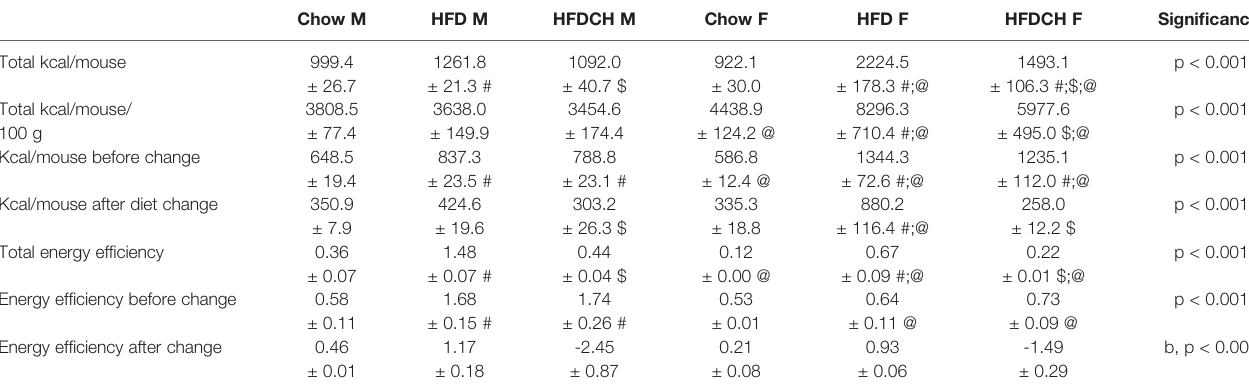
TABLE 4 | Energy intake parameters in male (M) and female (F) mice exposed to chow or to a high-fat diet (HFD) for 12 weeks, or 8 weeks of HFD intake and changed to a chow diet for 4 weeks